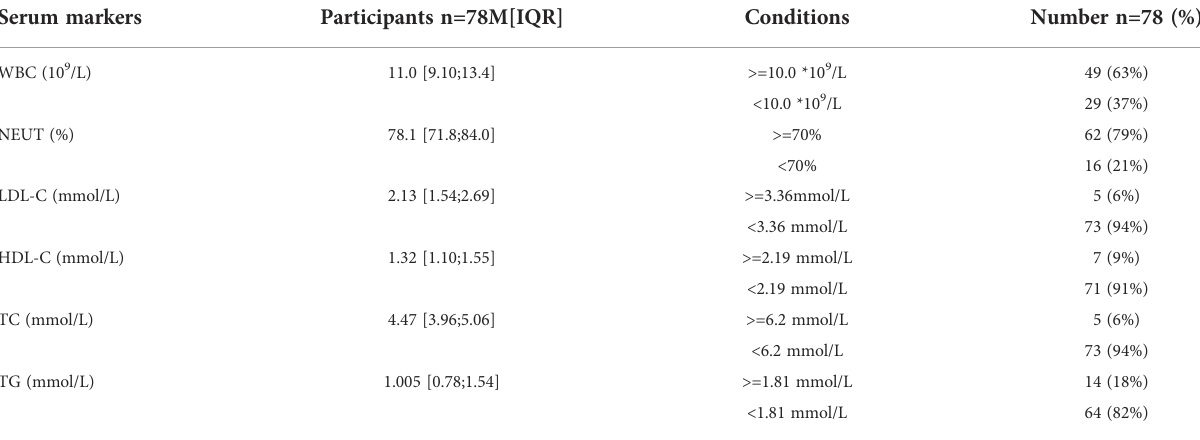
TABLE 3 The serum in fl ammatory and lipid levels in patients with AD. Serum markers